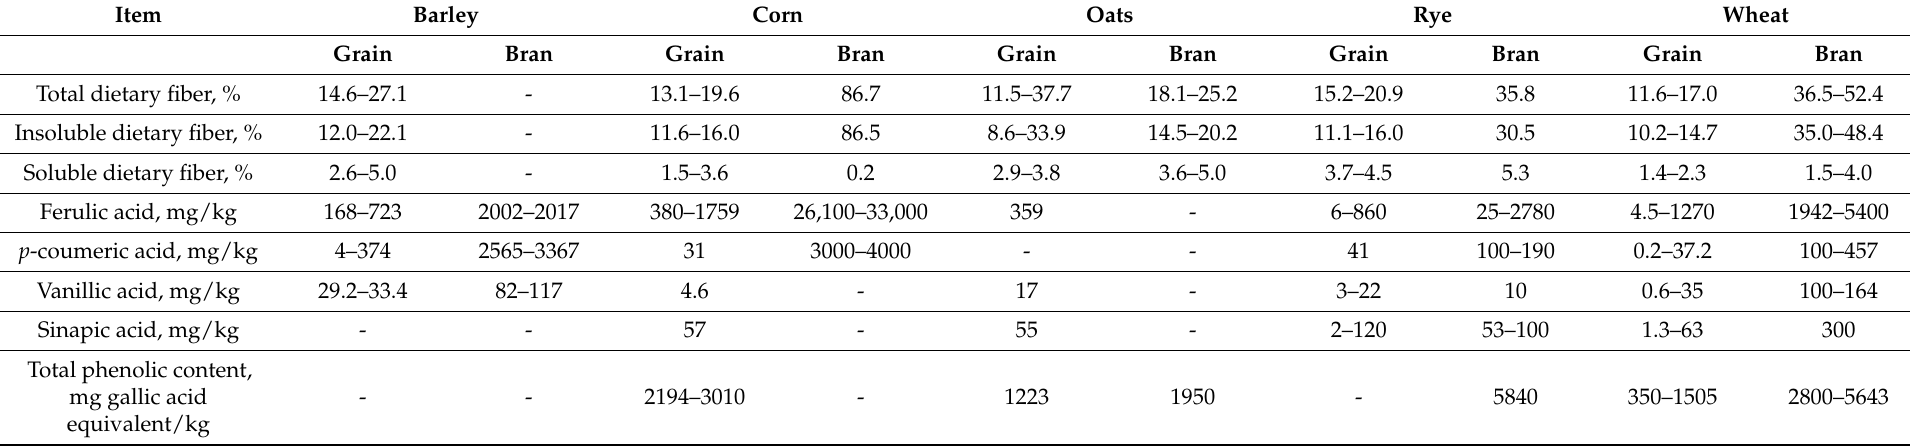
Table 15. Concentrations of total, insoluble, and soluble dietary fiber and phenolic acids in whole grain and bran fractions of common cereal grains (adapted from